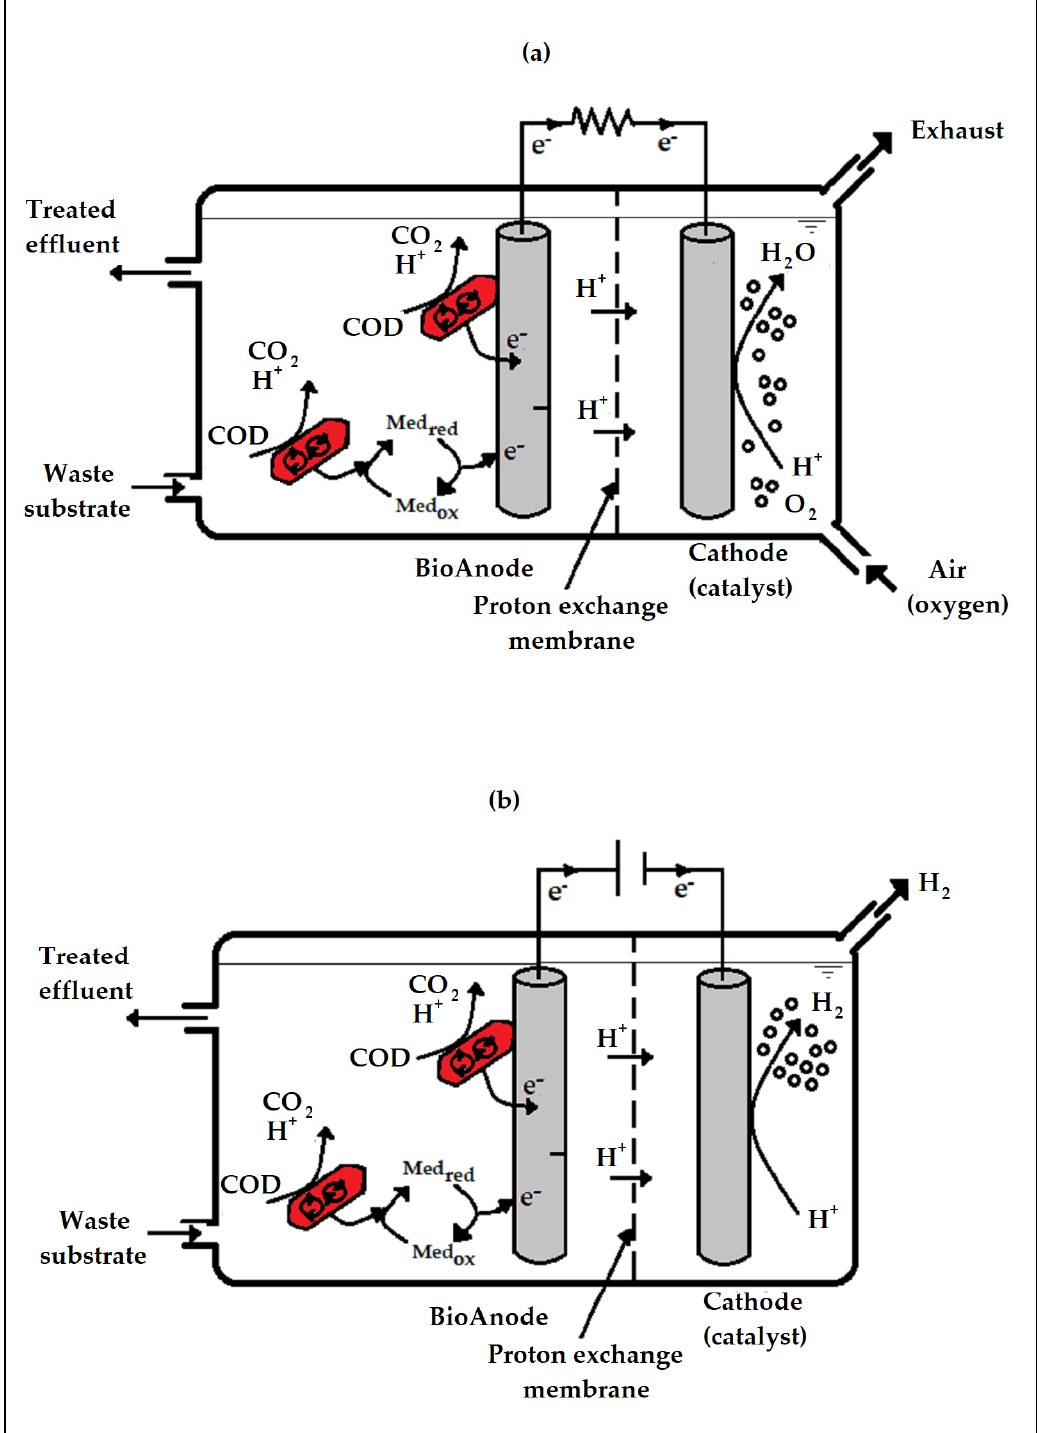
Figure 9. Schematic diagram of: ( a ) a MFC; and ( b ) a MEC. Adapted from [94]. In a MEC, as is the case with a MFC, electrochemically active microbes (exoelectro- gens) utilize the anode as a terminal electron receiver for the biochemical matter degrada- tion up to CO 2 whilst at the same time discharging protons to the wastewater [95]. The electron (e − ) moves from the anodic compartment to the cathodic compartment through an exterior circuit whereas the protons migrate to the cathodic section across a membrane that separates the electrodes [96,97]. At the cathodic compartment, in the existence of an